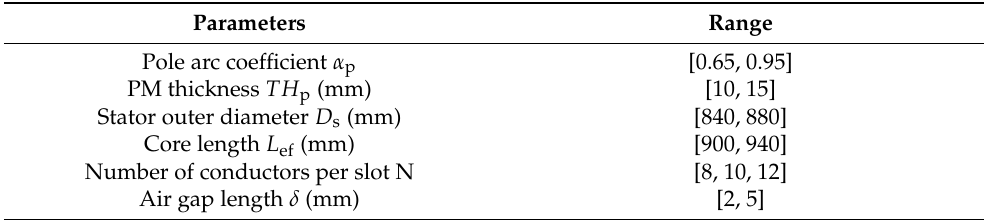
Table 2. Optimized design parameters and variation